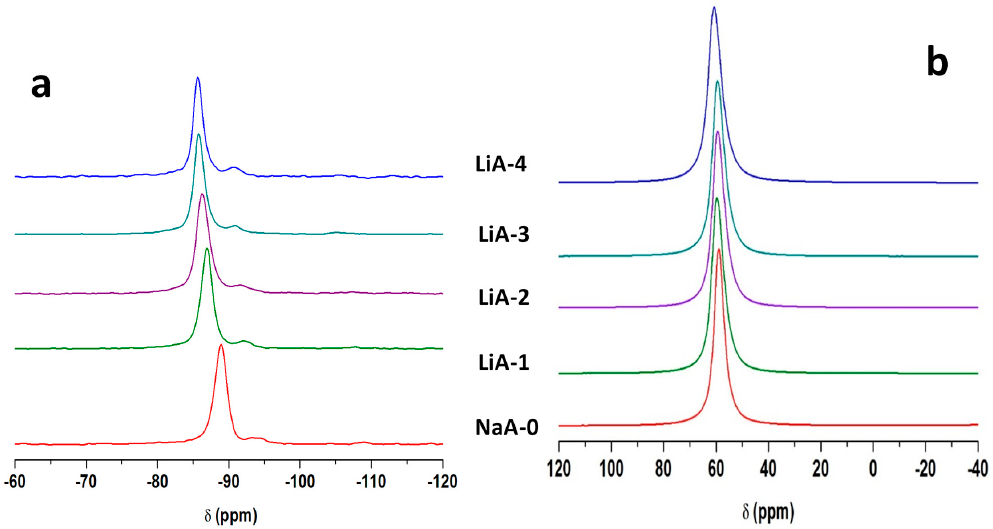
Figure 6. 29 Si-MAS NMR spectra ( a ) and 27 Al-MAS NMR spectra ( b ) of NaA-0 and its associated LiA-1 to LiA-4 samples. Only the isotropic region is